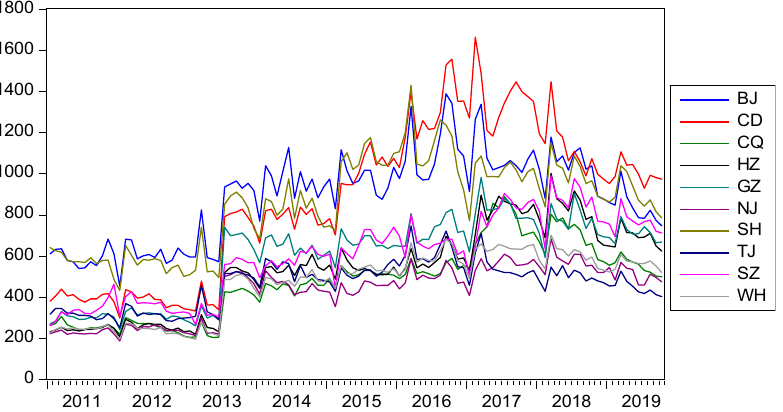
Figure 3. Real estate market information attention index trend chart.